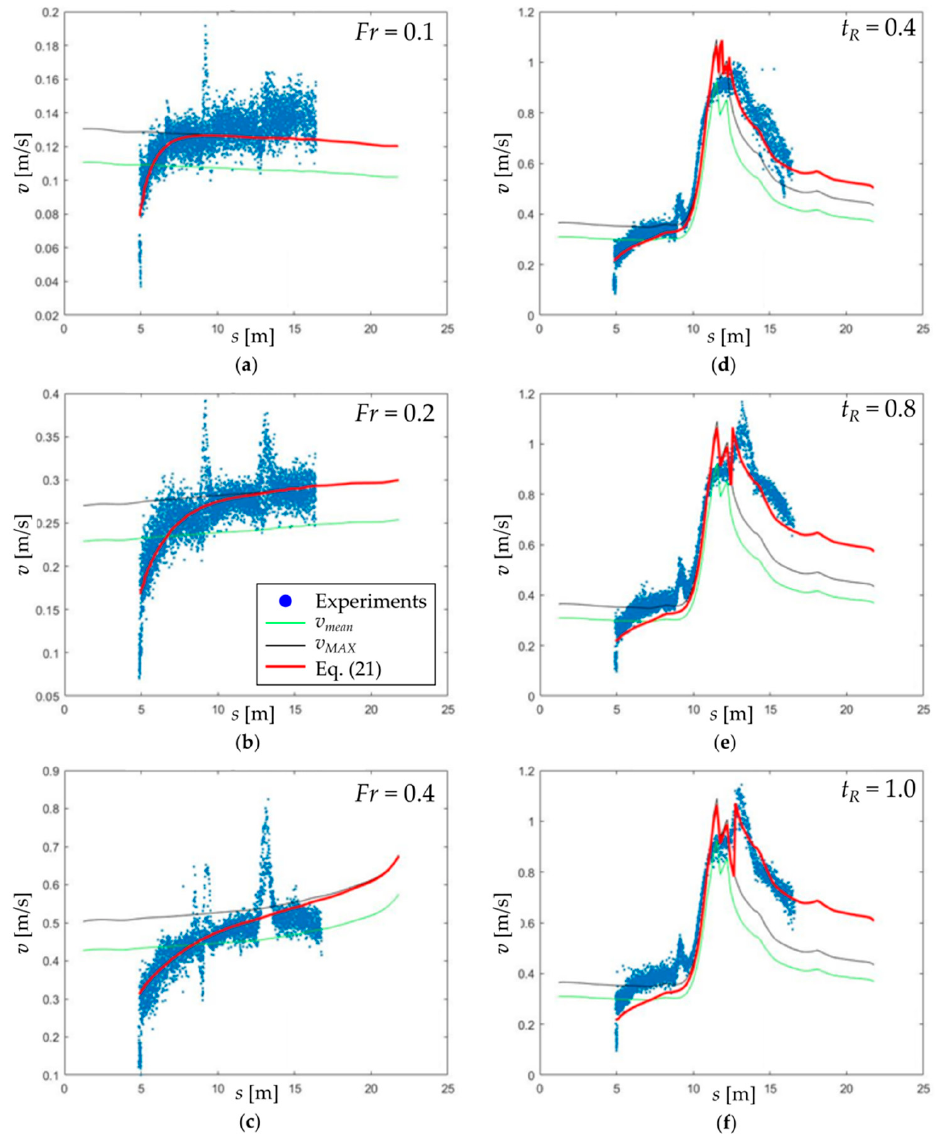
Figure 3. Comparison of the transport velocity (Equation (22)) with the experimental data, mean numerical v mean and maximum velocity v MAX for the S-shaped flume with ( a ) Fr = 0.1, ( b ) Fr = 0.2, ( c ) Fr = 0.4 and for the S-shaped flume with narrowing with ( d ) t R = 0.4, ( e ) t R = 0.8 and ( f ) t R = 1.